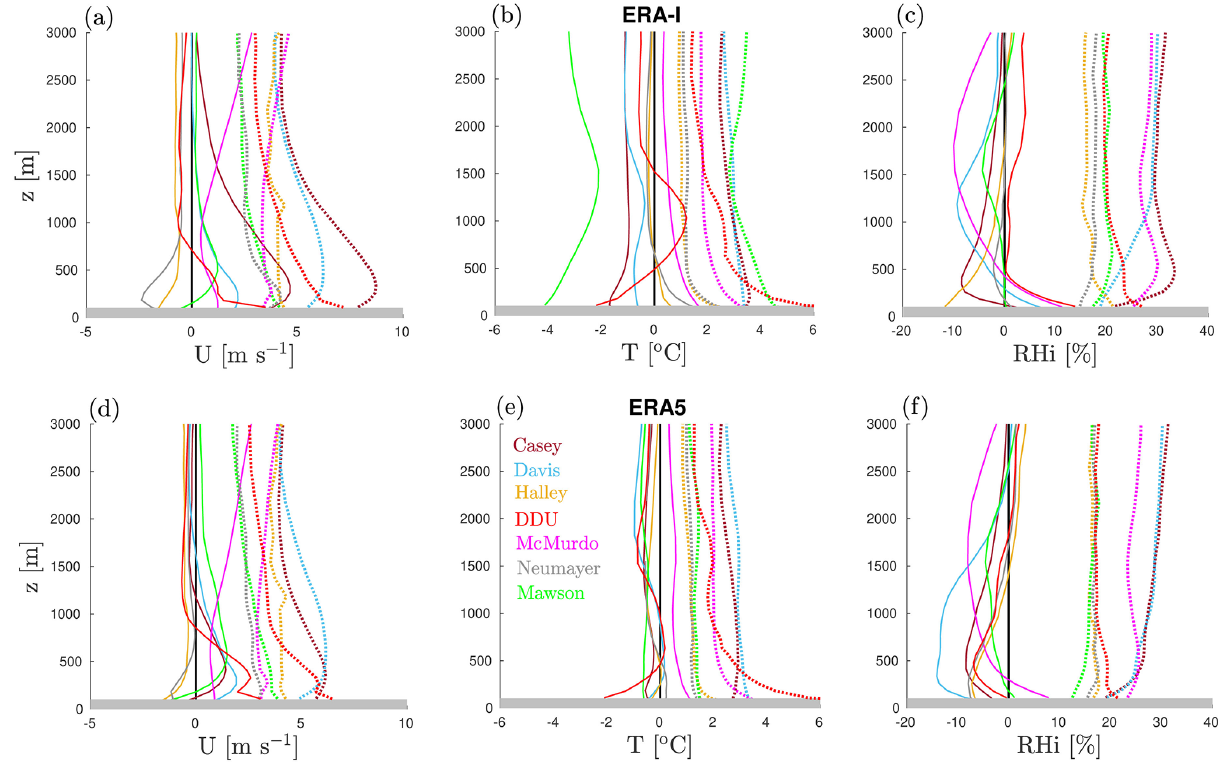
Figure 12. Mean bias (solid lines) and root mean square errors (dotted lines) in ERA-I (top row) and ERA5 (bottom row) with respect to radiosoundings at seven permanent Antarctic stations. Panels (a) and (d) show results for the wind speed, panels (b) and (e) results for the temperature, and panels (c) and (f) results for the relative humidity with respect to